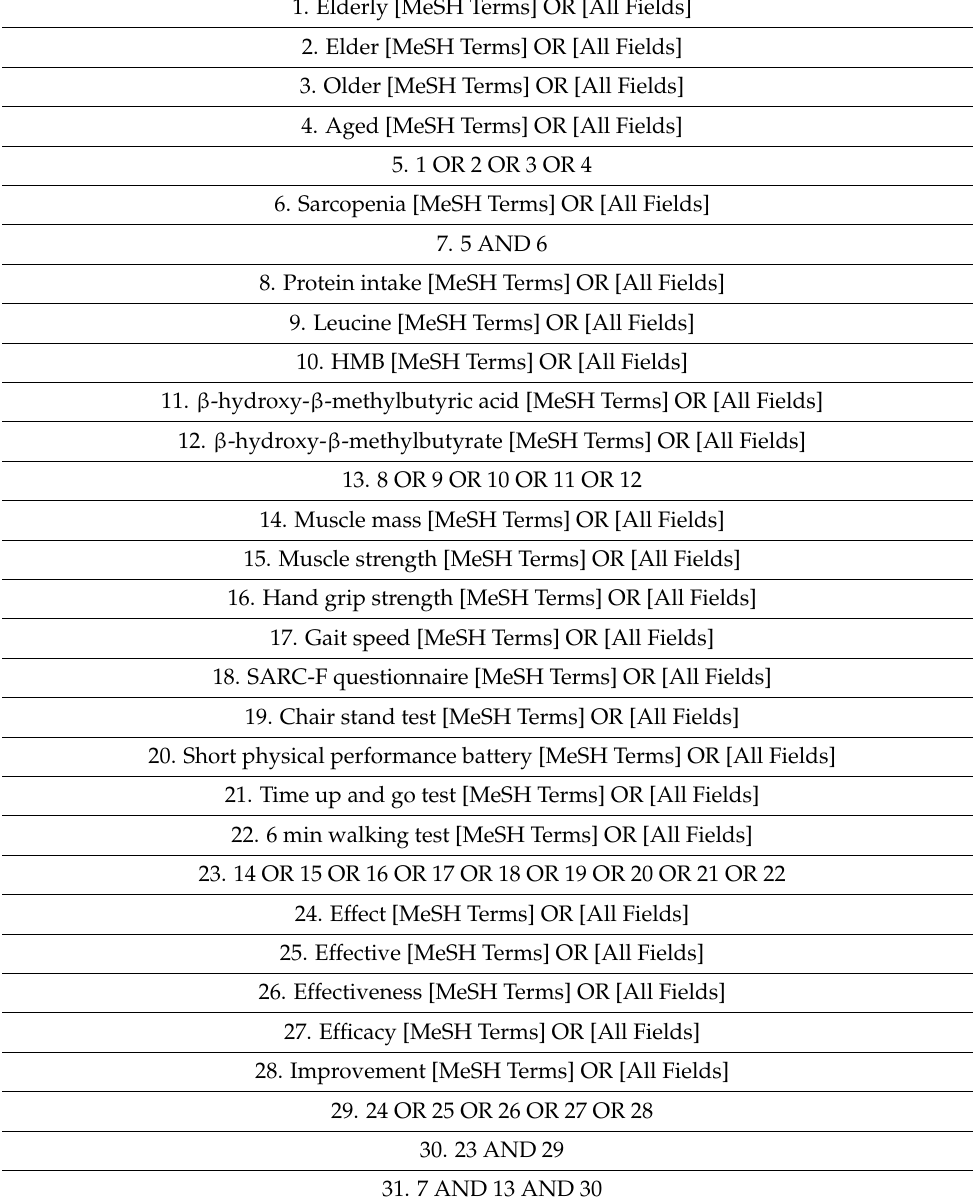
Table 1. Search strategy in PubMed till 20 May 2021 (similar search run in Cochrane